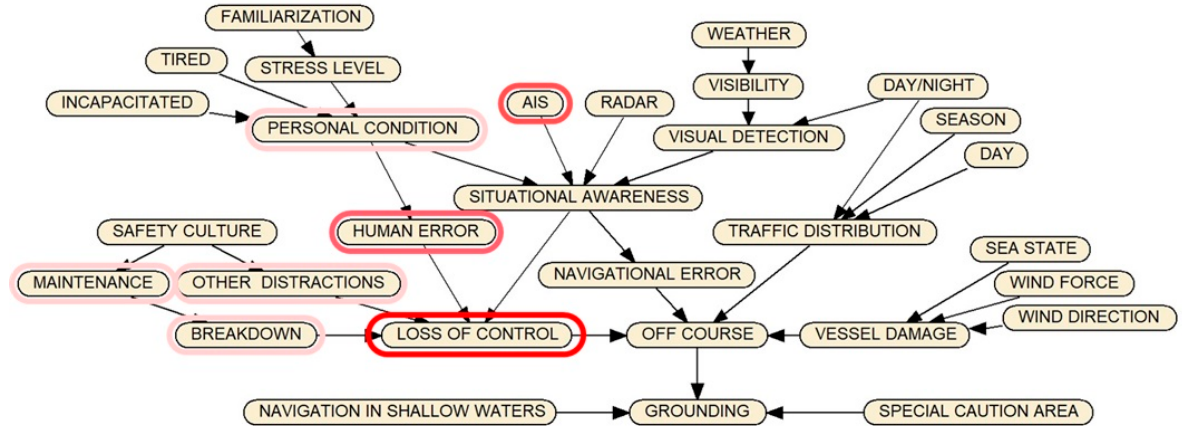
Figure 11. Candidate selection using the Lyapunov-based divergence measure.